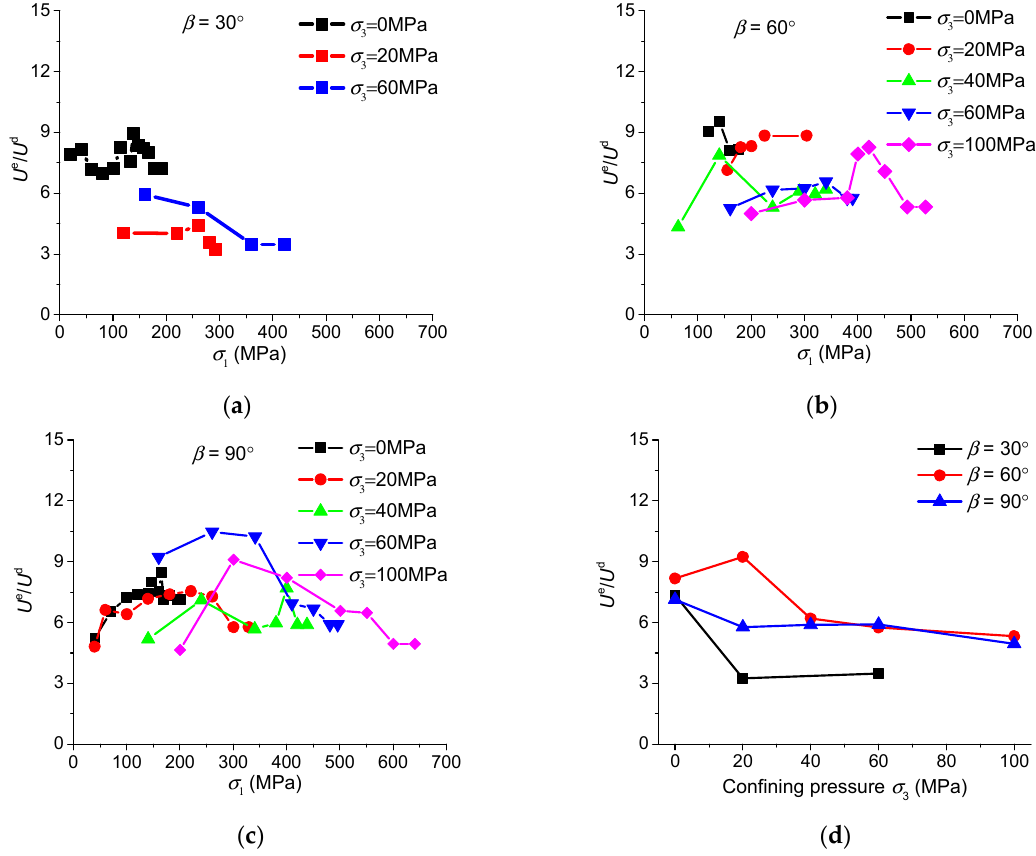
Figure 11. Ratio of releasable elastic strain energy U e to dissipated strain energy U d with the increase of axial stress for the shale samples with different oriented weak planes (( a ) β = 30 ° , ( b ) β = 60 ° , and ( c ) β = 90 °) under various confining pressures; ( d ) The ratio of U e / U d in the cycle of peak stress for the samples with different oriented weak planes under different confining pressures.